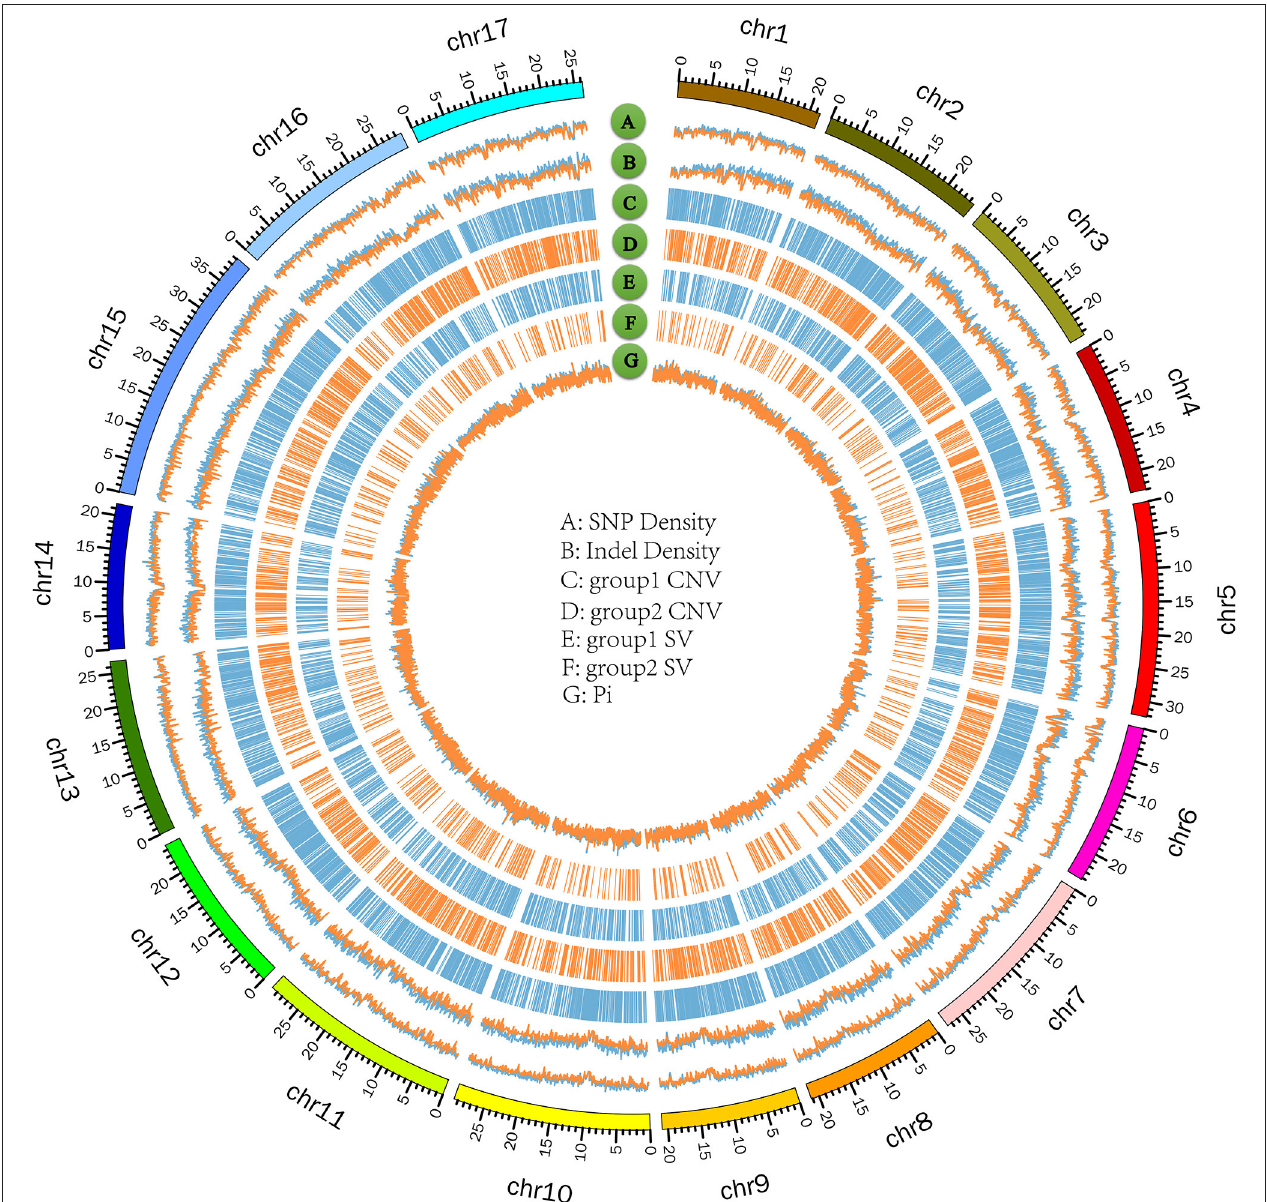
FIGURE 6 | Circos plot on 17 chromosomes of P. hopeiensis . (A) SNP density; blue refers to group 1, orange to group 2. (B) Indel density; blue refers to group 1, orange to group 2. (C,D) CNV in group 1 and group 2, including deletion and duplication. (E,F) SV in group 1 and group 2, including insertion and deletion. (G) Average number of nucleotide differences per site (pi); blue refers to group 1, orange to group 2. Group 1 contains P . hopeiensis HB-2, group 2 contains P . hopeiensis